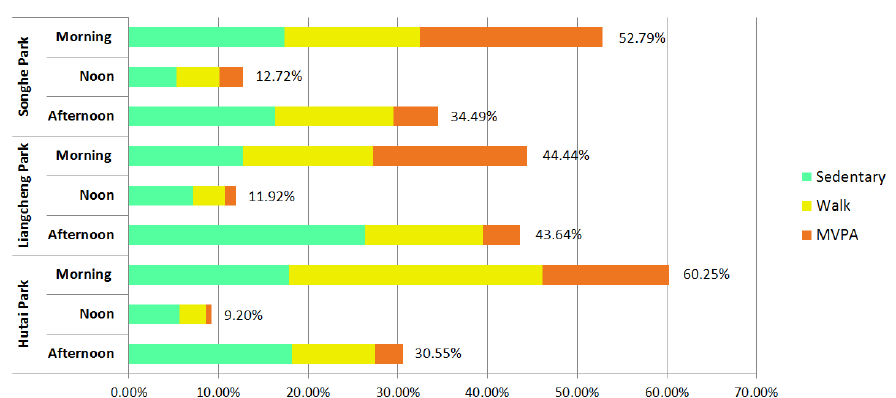
Figure 7. Percentage of park use by different time periods of the day.